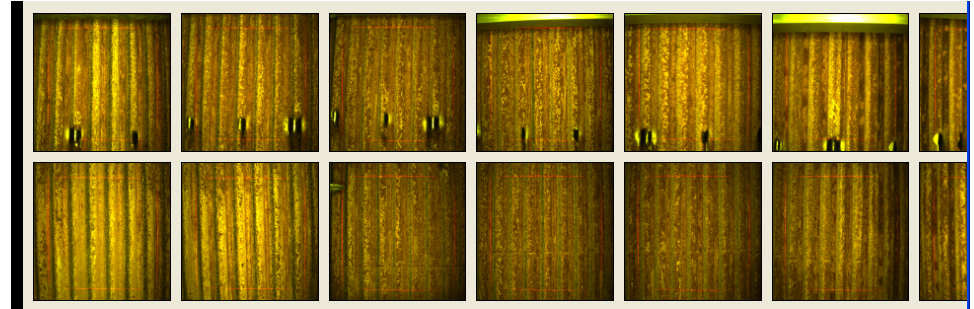
Figure 6. The example of a screenshot from the program aimed at processing and analyzing the evaporator photographs [93].